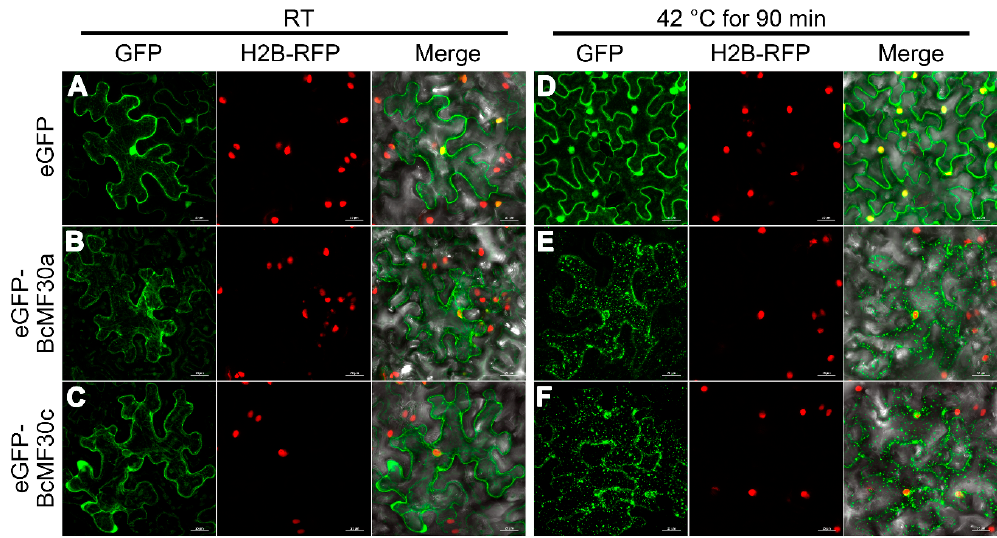
Figure 7. BcMF30a and BcMF30c can form cytoplasmic foci in Nicotiana benthamiana leaf epidermal cells after heat treatment. eGFP, eGFP-BcMF30a, and eGFP-BcMF30c were dispersed in the cytoplasm at room temperature (RT) ( A – C ). After heat treatment at 42 °C for 90 min, eGFP-BcMF30a and eGFP- BcMF30c could form cytoplasmic foci ( E , F ), while no cytoplasmic foci were observed for eGFP ( D ). H2B is a marker protein of the nucleus. Pictures represent white field images (Bright), epifluorescence (GFP and RFP), and merged images (Merge). Bar =25 μ m.